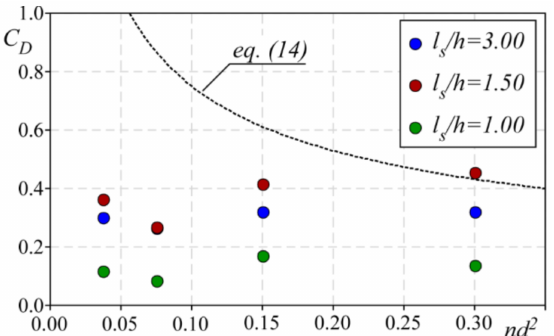
Figure 10. Experimental drag coefficient C D versus dimensionless density nd 2 . Dotted black line shows the drag coefficient predicted by Equation (14) for Re = 135 in oscillatory